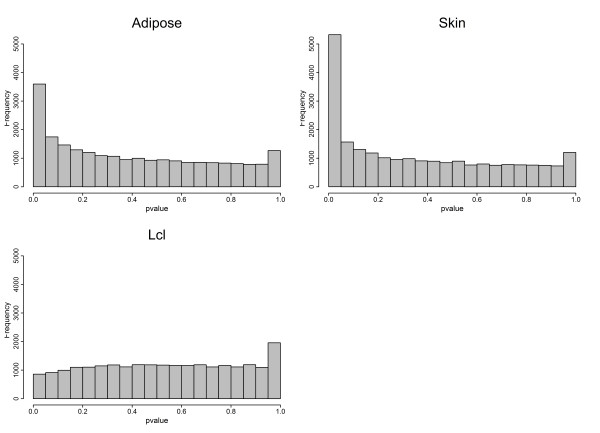
Venn diagram showing the overlap between significant age-affected genes in skin and adipose tissues (Benjamini-Hochberg corrected Pvalue < 0.01).